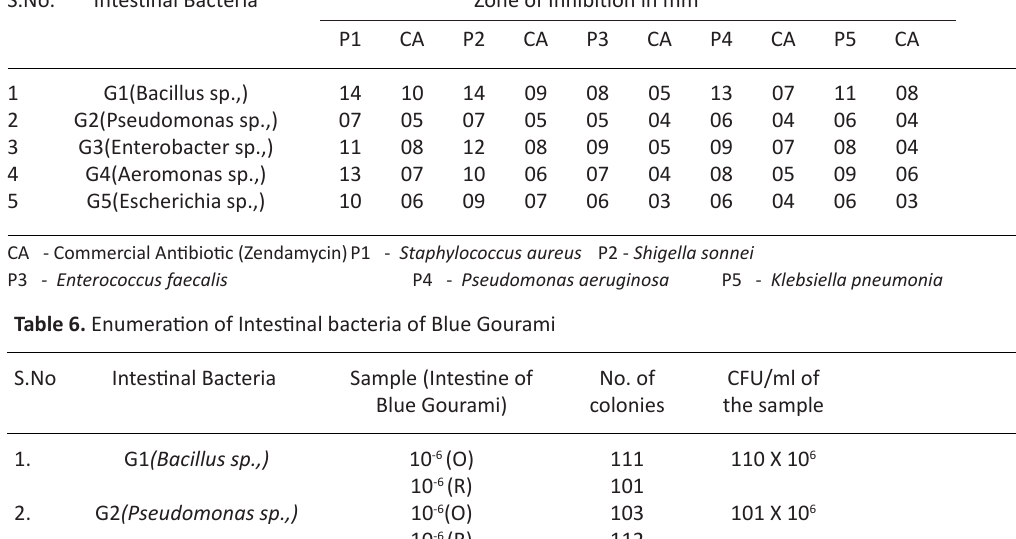
Table 5. Antibacterial Activity (Double layer screening) of intestinal bacteria of Blue Gourami